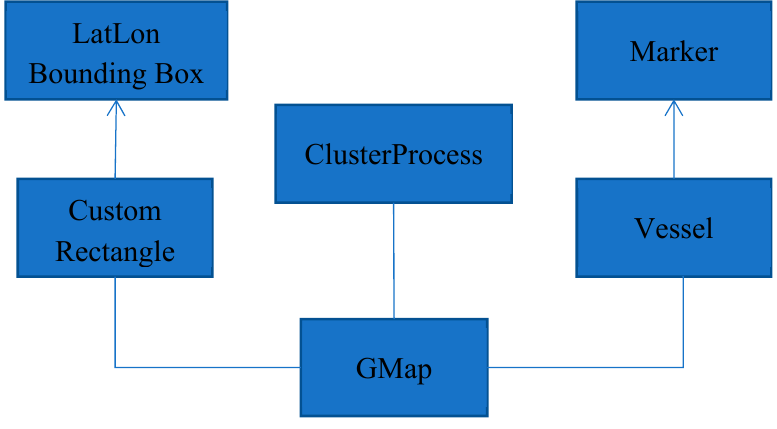
Figure 9. Class connection flowchart.